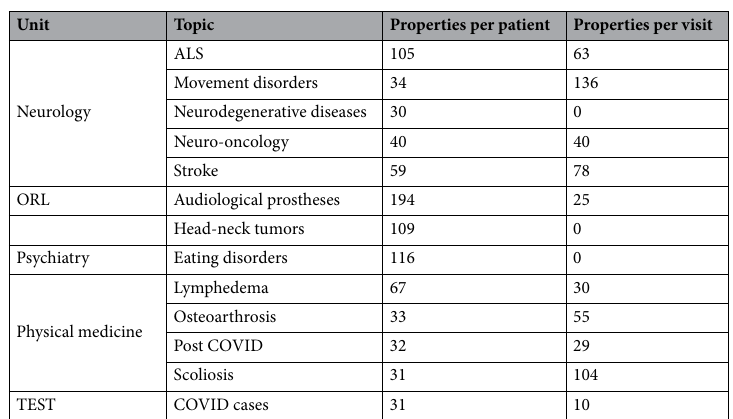
Table 1. Implemented database schemata: list of the currently implemented database schemata at the Neuroscience Department, University of Padova.